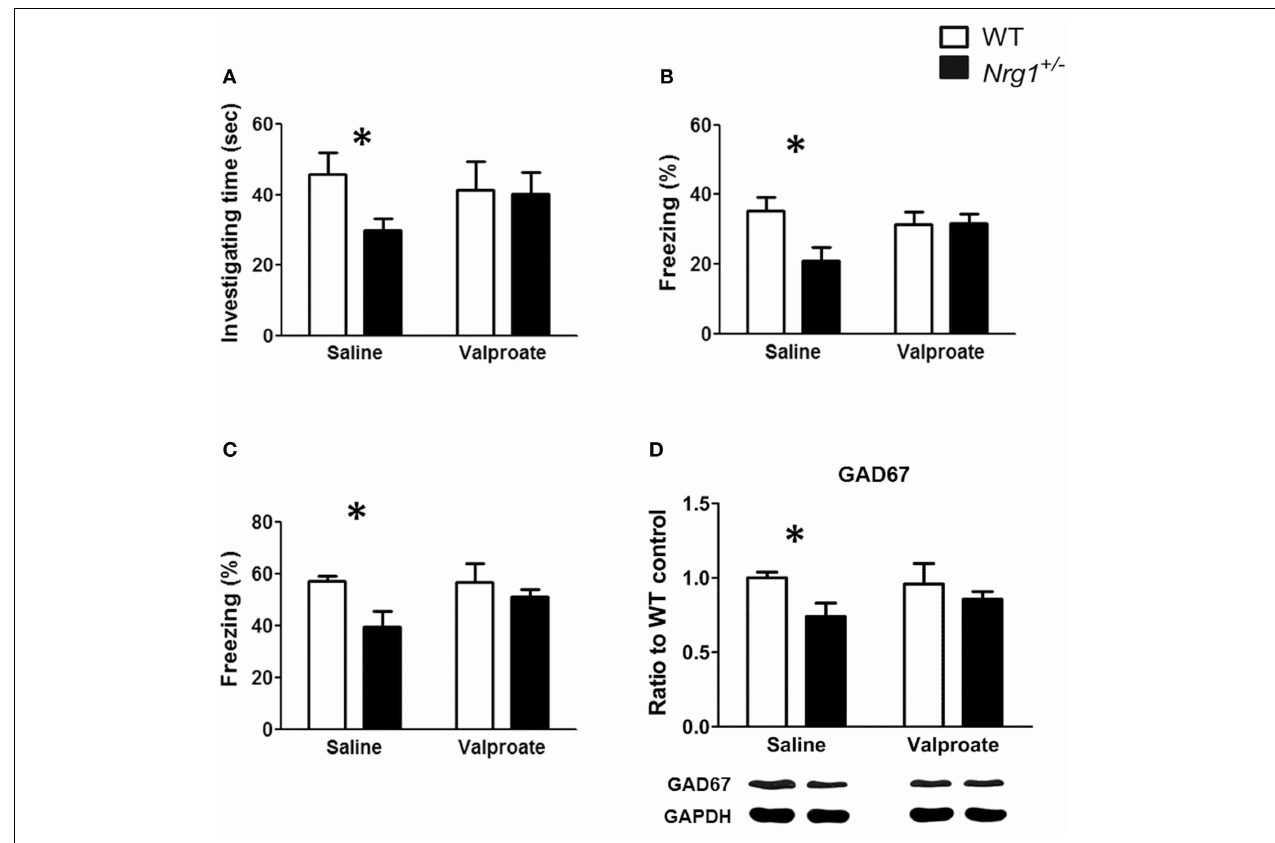
FIGURE 5 | The effect of chronic valproate treatment on the rescue of cognitive deficits in male wild-type (WT, white bars) and TMc- Nrg1 + / − mutant (black bars) mice. Three cognitive tasks, including (A) an object recognition task, (B) a contextual fear conditioning task, and (C) a cued fear conditioning task, were conducted. Either valproate (1.5mmol/kg, s.c.) or 0.9%